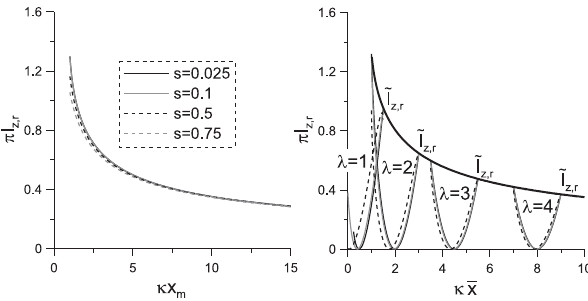
Fig. 3. Left panel: the dependence of κx m on I z for various values of s . Right panel: I z as a function of κ ¯ x from the left panel and corresponding dependencies for various λ